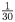
The Redfern et al. derivation is tacitly based on the assumption that the hERG safety margin consists of the exposure range between the TFPCmax and the maximum FPCmax due to DDI, overdose, or other factors, equating to TFPCmax ≤ 130 hERG IC50.For the present purpose, we assume that arrhythmia (the primary origin of organ-level TdP) occurs at ~50% block of the open hERG population in otherwise normal M cells (corresponding to the apparent IC50), and possibly much lower in the diseased heart, translating to an absolute Δ(exposure)-based Redfern SI = hERG IC50 –hERG IC50/30.